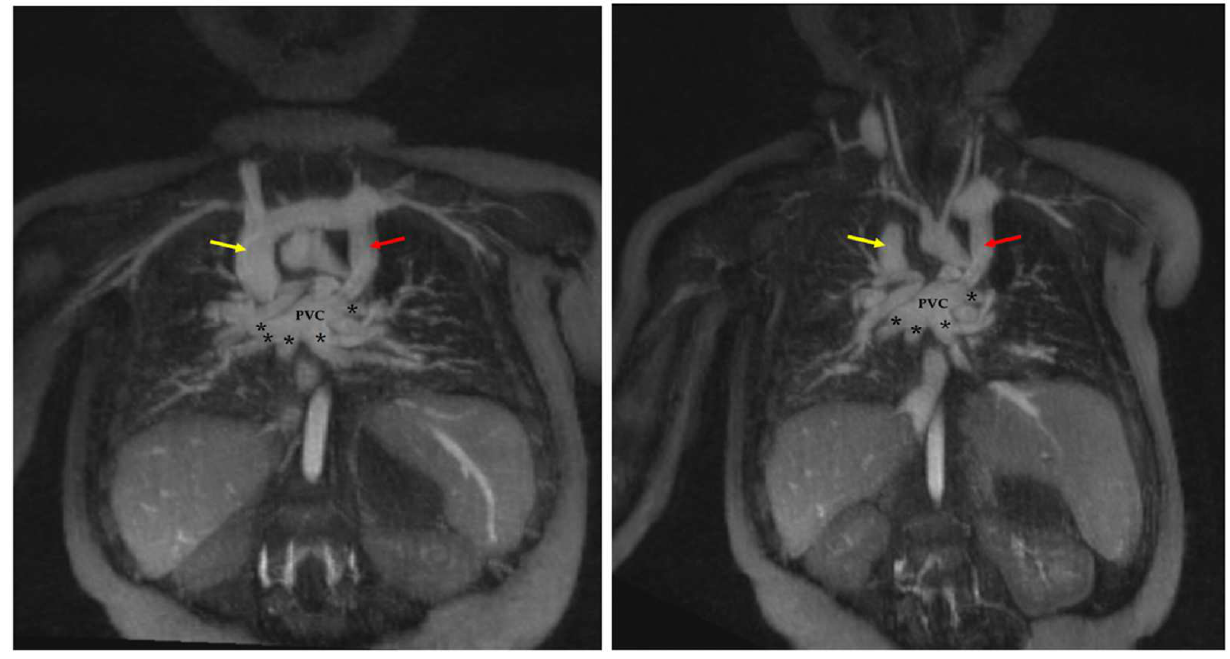
Figure 1. Total Anomalous Pulmonary Venous Connection (TAPVC), supracardiac type. In this neonate, coronal reconstructions from ferumoxytol-enhanced 4D MRA (MUSIC) clearly show abnormal connection of the pulmonary veins (black asterisks) connections to a pulmonary venous confluence (PVC), rather than the left atrium. Pulmonary venous blood then drains via superior “vertical veins” (red arrows), innominate vein, and then to the dilated right superior vena cava (yellow arrow).